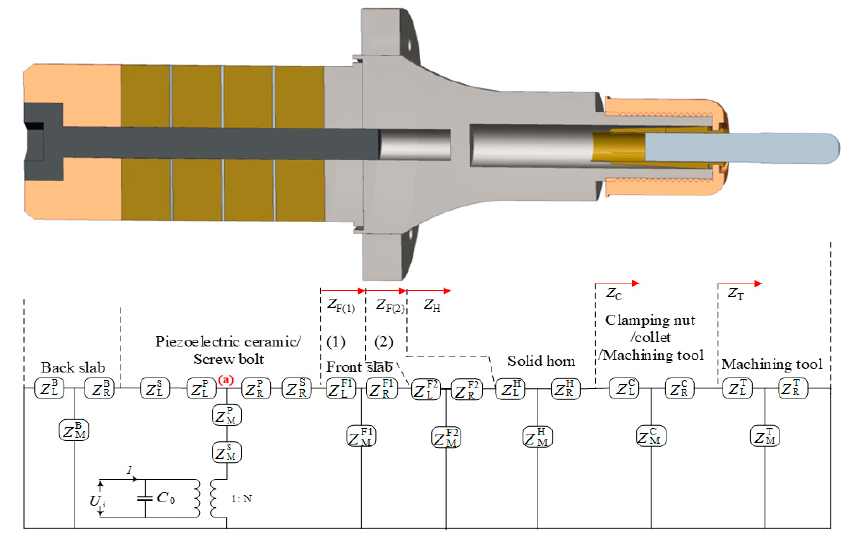
Figure 3. The equivalent circuit model of the ultrasonic transducer.